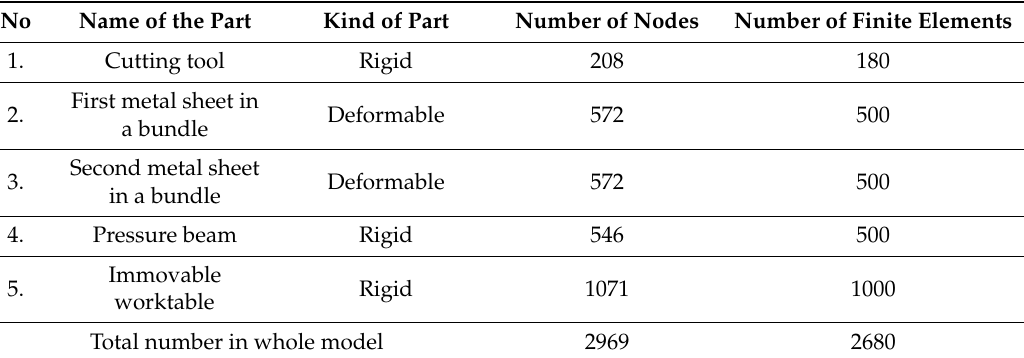
Table 2. Details concerning parts discretisation.